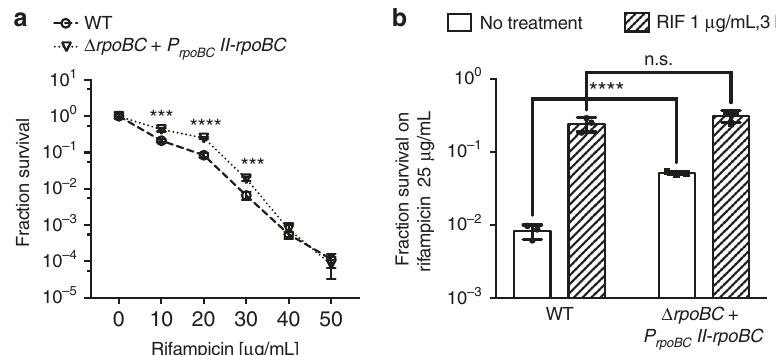
Fig. 5 Disruption of the rpoB promoter architecture alters RSPR. a Fractional survival on 25 µ g ml − 1 rifampicin-agar of wild-type M. smegmatis or M. smegmatis with only Promoter II-driven rpoB-rpoC at the Giles chromosomal location. Data represent biological triplicates. *** p < 0.001 and **** p < 0.0001 by Student ’ s t- test. b Cultures of the two strains in ( a ) were pretreated with 7H9 ± 1 µ g ml − 1 rifampicin for 3 h and then plated on rifampicin-agar and fractional survival calculated. Data represent biological triplicates. **** p < 0.0001 by Student ’ s t- test, n.s. no signi fi cant difference by Student ’ s